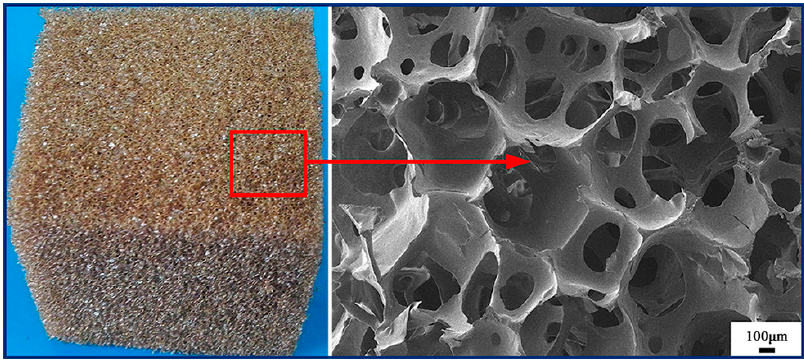
Figure 8. Camera photo and SEM image of rigid polyurethane (RPU) foams from liquefied products .